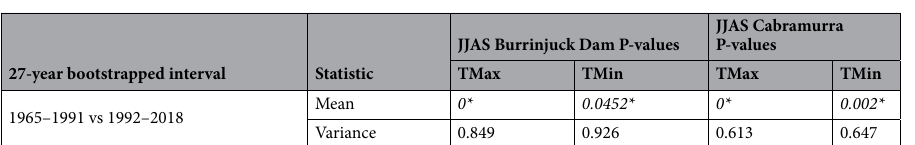
27-year bootstrapped